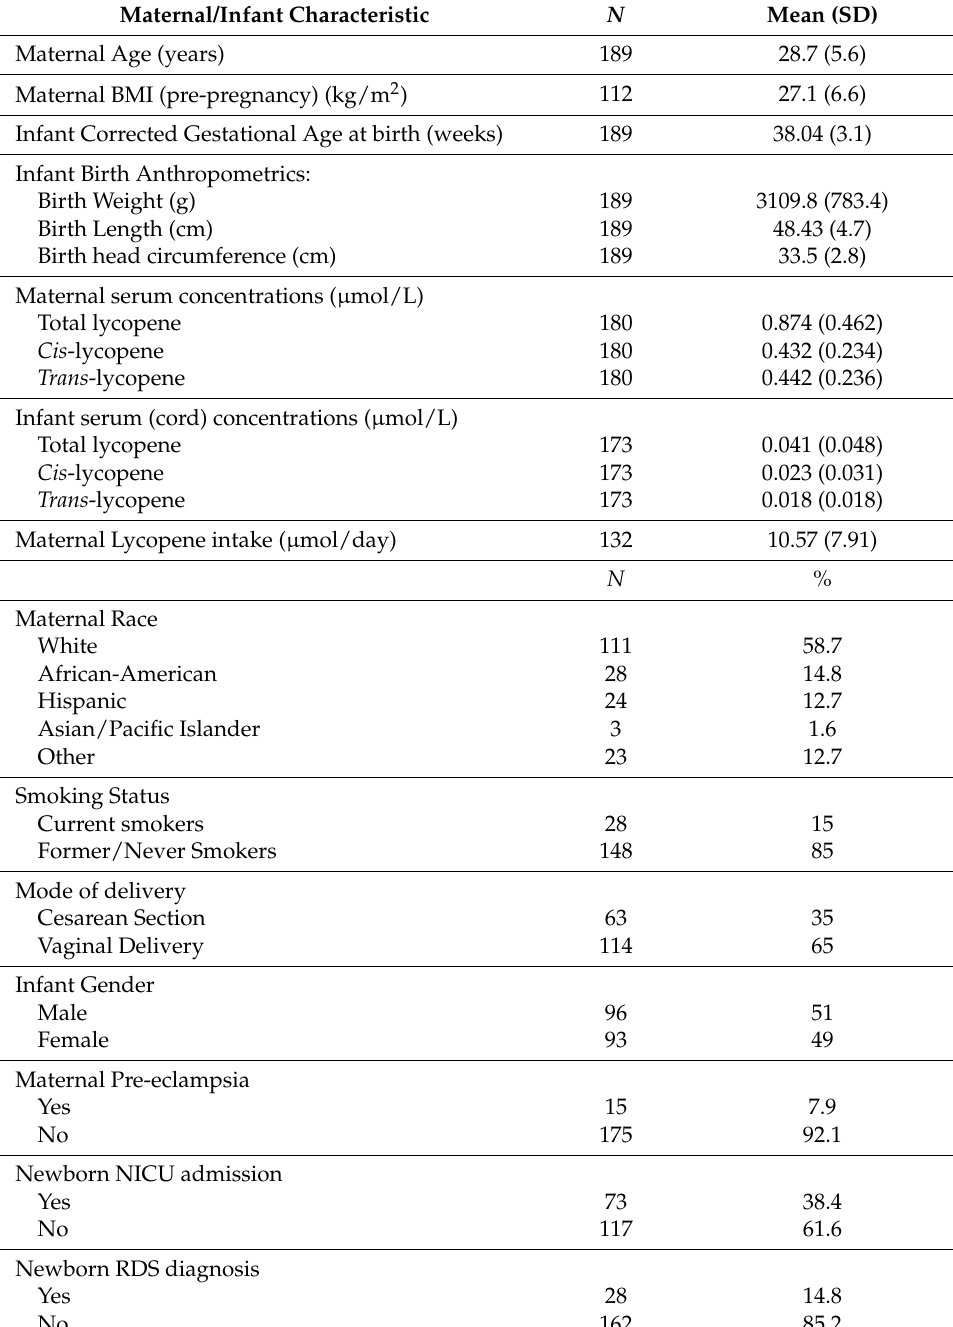
Table 1. Demographic and clinical characteristics of the maternal and infant